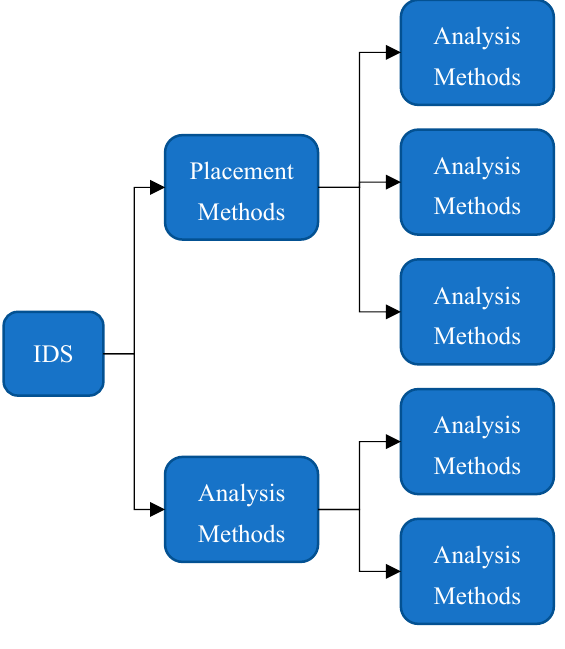
Figure 1. IDS categories.